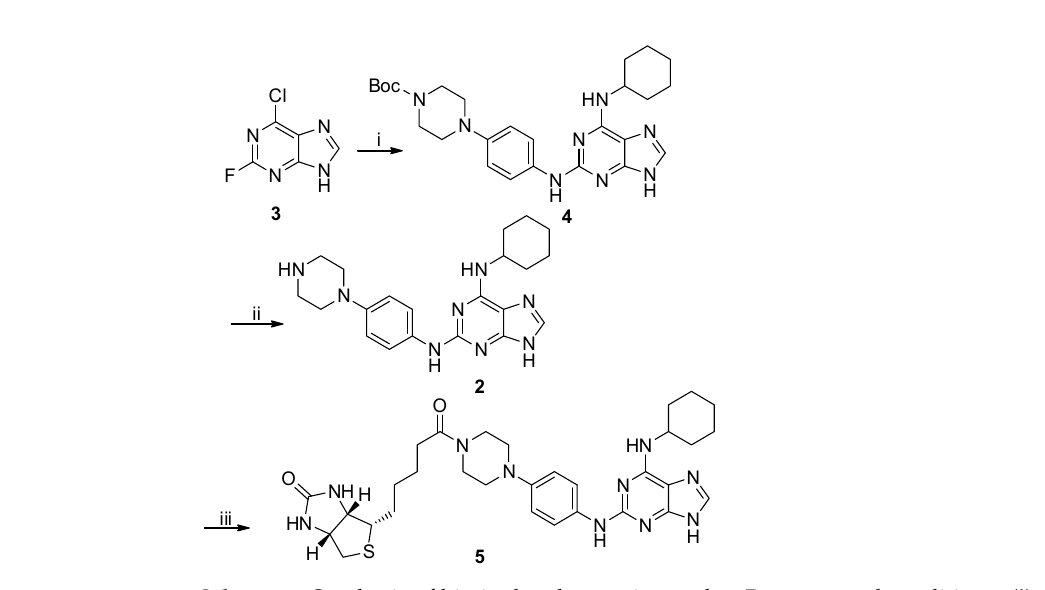
Scheme 1. Synthesis of biotinylated reversine probe. Reagents and conditions: ( i ) (a) cyclohexyla- mine, DIPEA, n-BuOH, 80 °C, 24 h, (b) tert-butyl 4-(4-aminophenyl) piperazine-1-carboxylate, EtOH, 81% yield over two steps; ( ii ) HCl, i-PrOH, 97% yield; ( iii ) biotin, ECDI, DMAP, DMF, 75% yield.